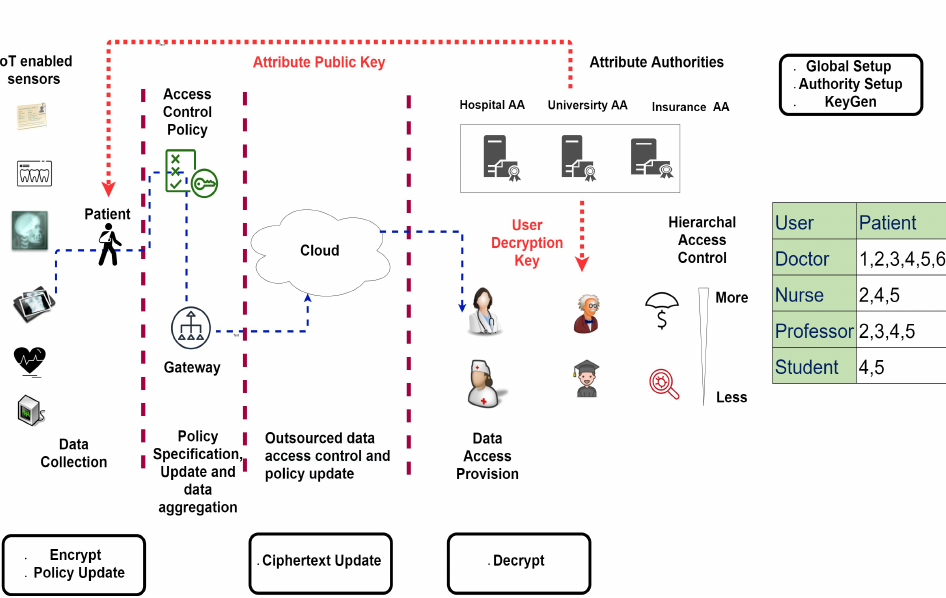
Figure 1. System Model of